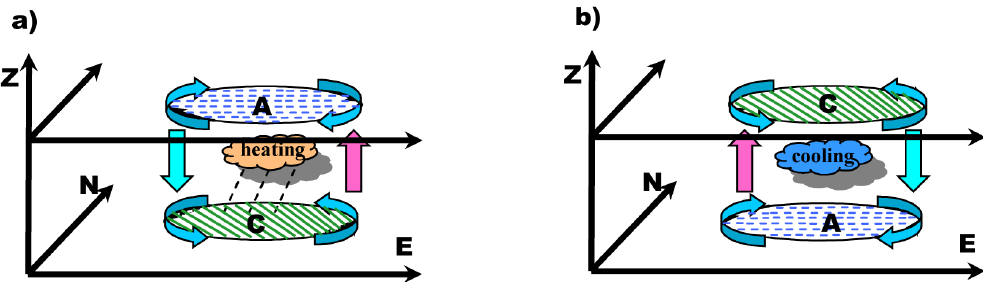
Fig. 2. Schematic diagram showing atmospheric adaptation on the rotating earth to external heating in the summertime subtropics: (a) Di- abatic heating generates cyclonic circulation (C) near the surface and anticyclone circulation (A) in the upper troposphere, with air ascent developing over the eastern part of the circulation and descent over the western part. (b) Diabatic cooling generates anticyclonic circulation near the surface and cyclone circulation in the upper troposphere, with air descent developing over the eastern part of the circulation and ascent over the western part.